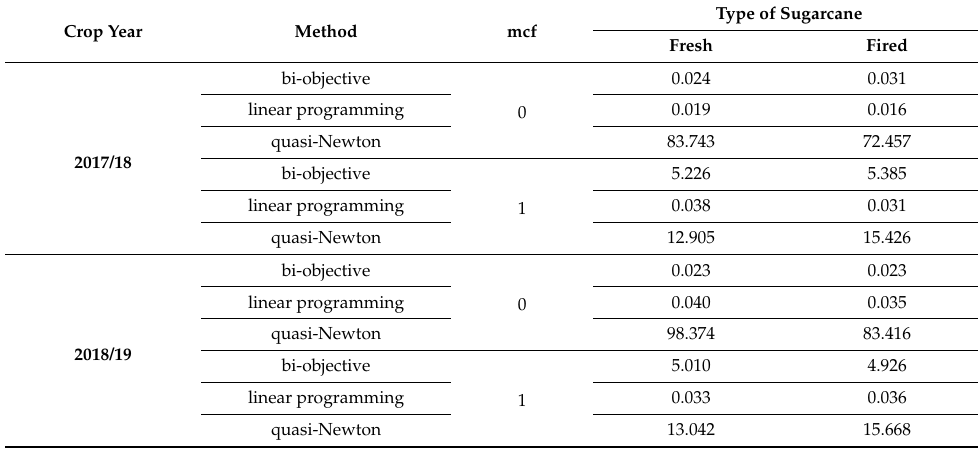
Table 9. CPU time (seconds) of fresh and fired sugarcane cutting in each 15-day period in crop year 2017/18 and